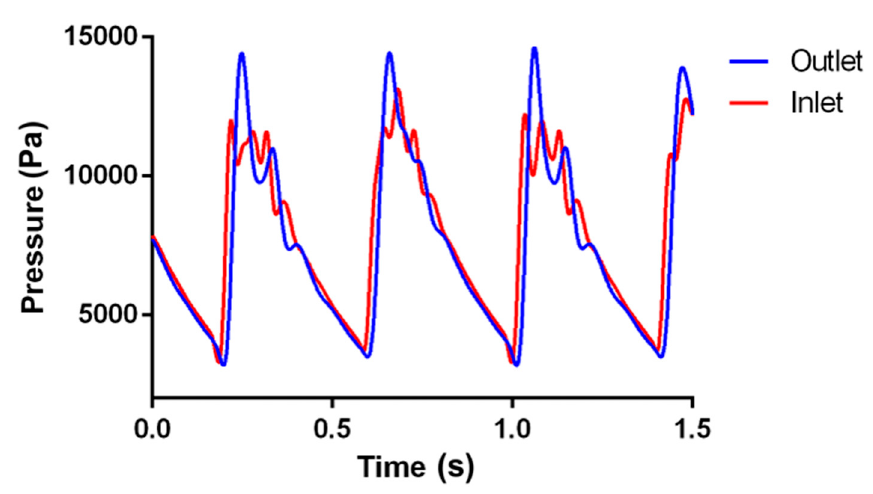
Figure 8. Experimental pressure measurements at the inlet and outlet of the fluidic system under a